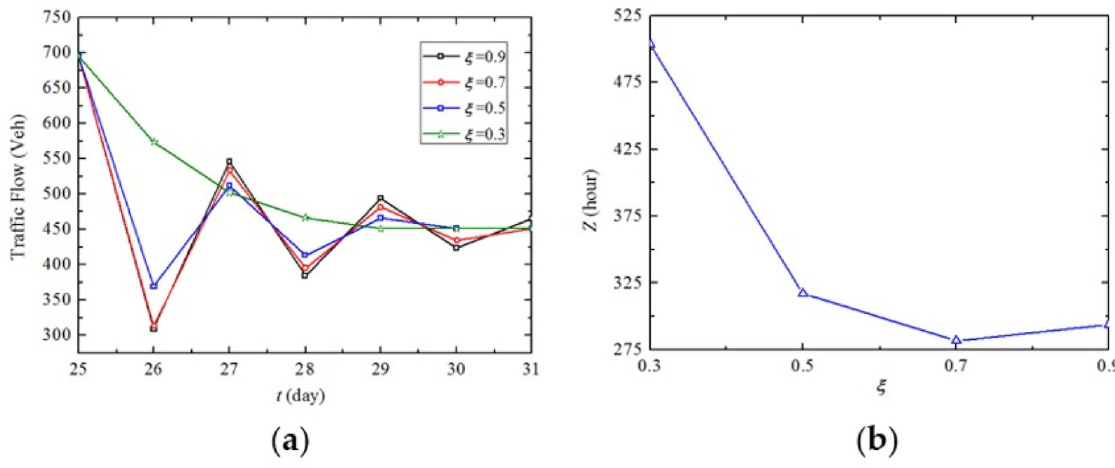
Fig 10. Impact of the parameter ξ on traffic flow and increased traffic delays on Link